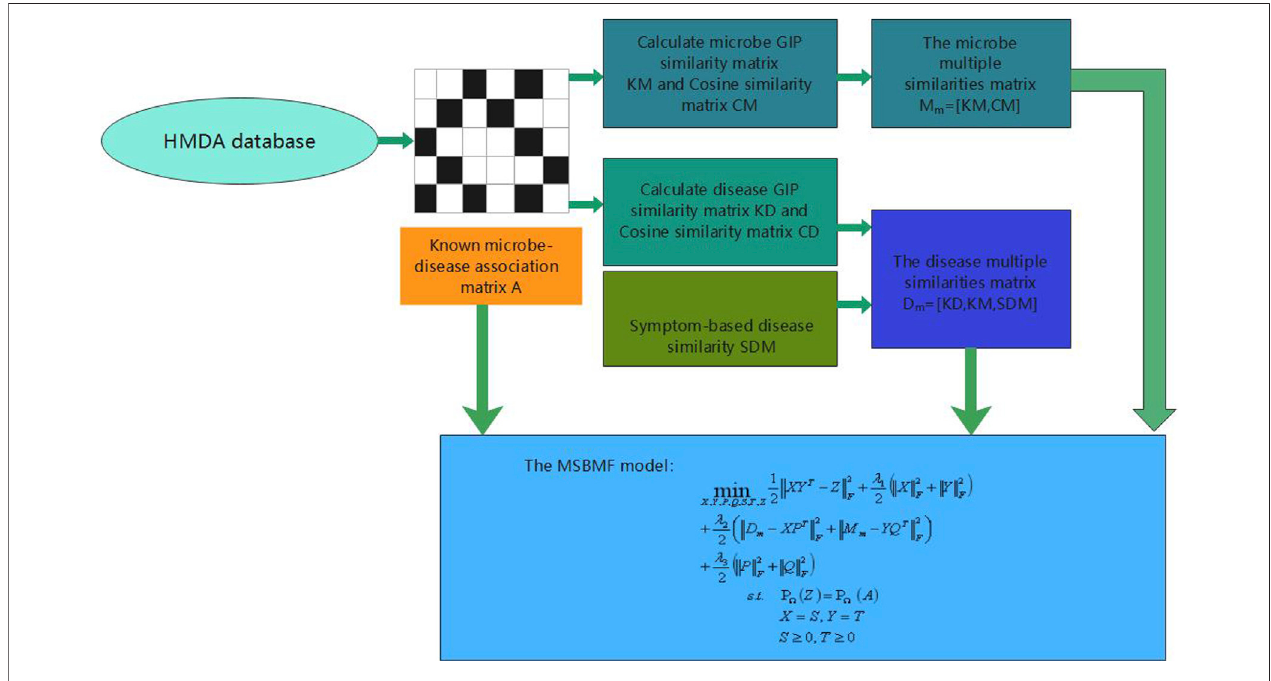
FIGURE 1 | The overall work fl ow of